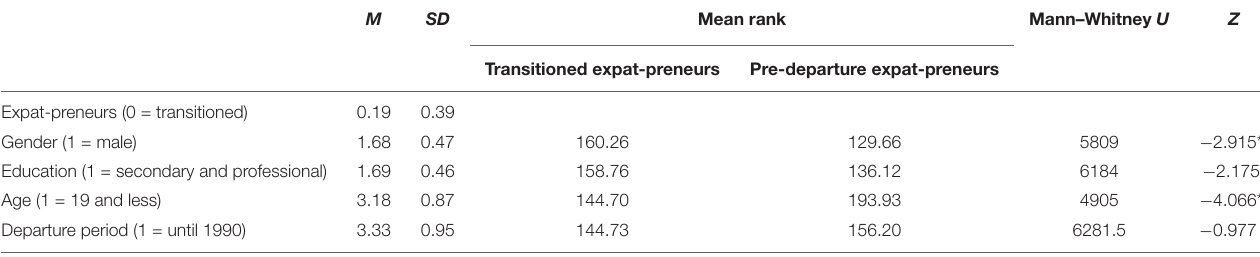
TABLE 3 | Comparative analysis matrix for demographic variables.